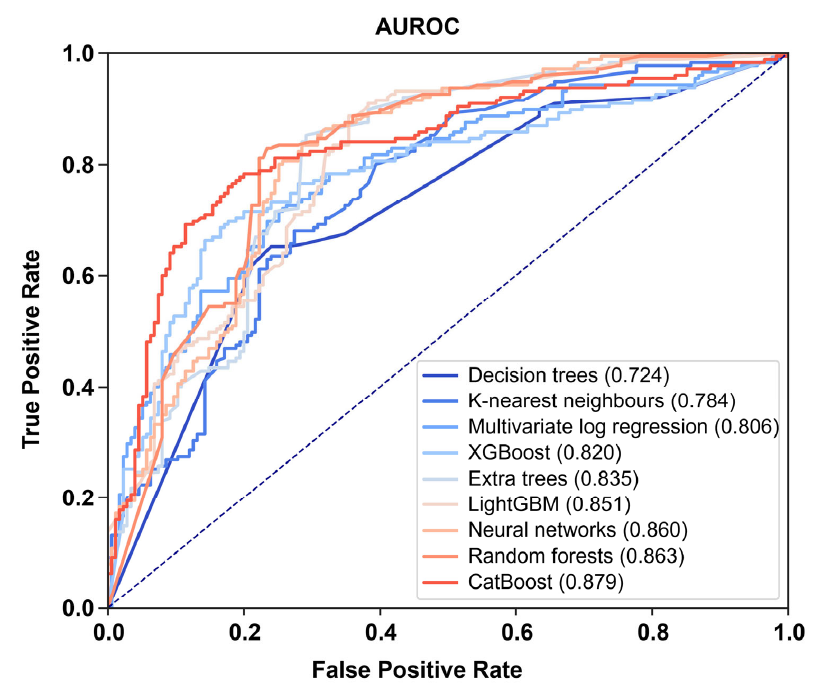
Figure 3. ROC curves and AUROC values for the best models developed by distinct ML algorithms. Table 3. Comparison of AUROC values for the best models developed by distinct ML algorithms.